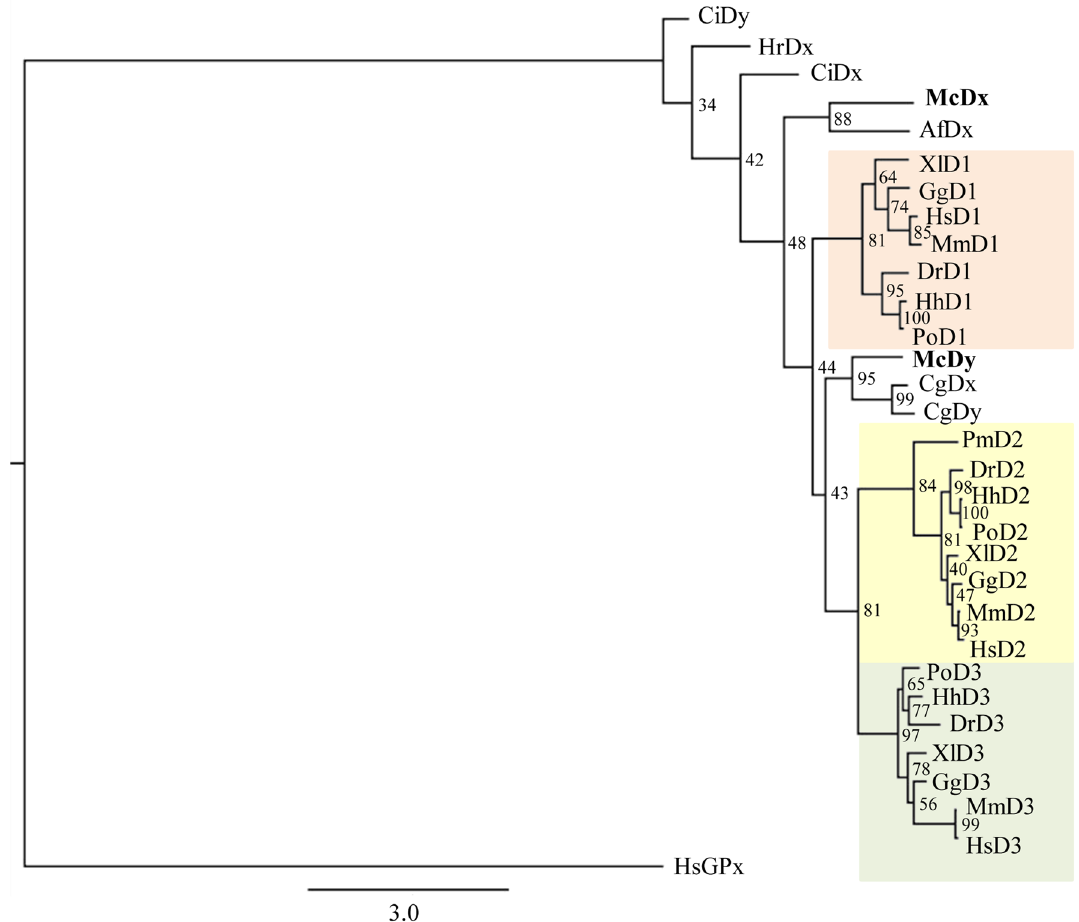
Figure 3. Phylogenetic analysis of two M. coruscus deiodinases with other metazoan homologues. The tree was built using the maximum-likelihood (ML) method based on the full-length amino acid sequence of deiodinases. The chordate D1 and a cluster include McD1, AfDx and SpD1 were boxed in pink, the chordate D2 in yellow and the chordate D3 in green. The sequence of two M. coruscus deiodinases are highlighted in bold. The tree was rooted with the sea anemone iodotyrosine deiodinase 1 (IYD1, XP_001633169). HsD1 ( H. sapiens , AAB23670), HsD2 ( H. sapiens , AAD45494), HsD3 ( H. sapiens , AAH17717), MmD1 ( Mus musculus , NP_031886), MmD2 ( M. musculus , NP_034180), MmD3 ( M. musculus , AAI06849), GgD1 ( G. gallus , NP_001091083), GgD2 ( G. gallus , AAD33251), GgD3 ( G. gallus , NP_001116120), XlD1 ( X. laevis , AAZ43088), XlD2 ( X. laevis , AAK40121), XlD3 ( X. laevis , AAA49971), DrD1 ( D. rerio , NP_001007284), DrD2 ( D. rerio , NP_997954), DrD3 ( D. rerio , NP_001242932), PoD1 ( Paralichthys olivaceus , BAG15906), PoD2 ( P. olivaceus , BAG15907), PoD3 ( P. olivaceus , BAG15908), HhD1 ( Hippoglossus hippoglossus , ABI93488), HhD2 ( H. hippoglossus , ABI93490), HhD3 ( H. hippoglossus , ABI93489), PmD2 ( Petromyzon marinus , KC306946), HrDx ( H. roretzi , AAR25890), CiDx ( C. intestinali ; XP_026689666); CiDy ( C. intestinali ; XP_009859641); CgDx ( C. gigas AKF17655), CgDy ( C. gigas AKF17656), AfDx ( A. farreri , AEX08671), McDx ( M. coruscus , MW928627) and McDy ( M. coruscus ,